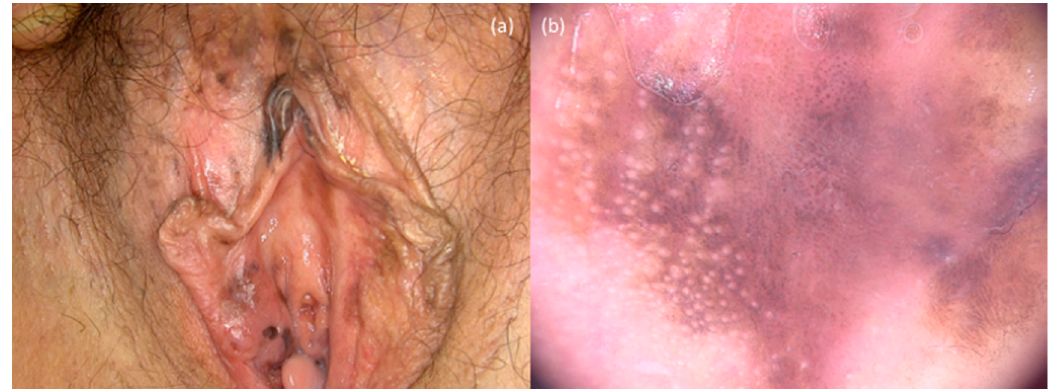
Figure 7. Vulvar melanoma. The clinical image ( a ) shows multiple irregular-shaped brown/black macules. Dermoscopy ( b ) reveals black/blue and white structureless areas, regression areas, irregular blue/gray dots and an atypical brownish digitiform pattern.